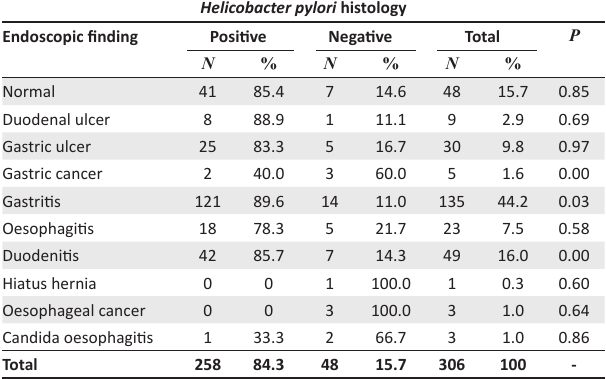
TABLE 4: Endoscopic finding with distribution of Helicobacter pylori at histology. Helicobacter pylori histology Endoscopic